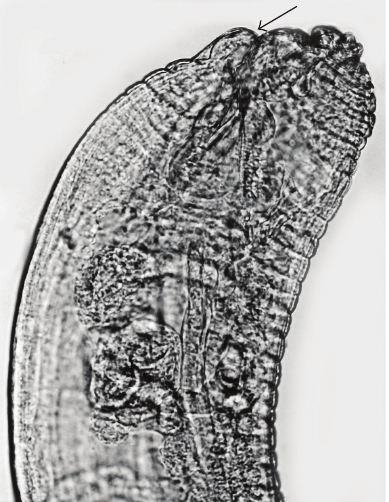
Figure 17: Parasitic female of an undescribed allantonematid from workers of Cephalotes christopherseni in Peru.